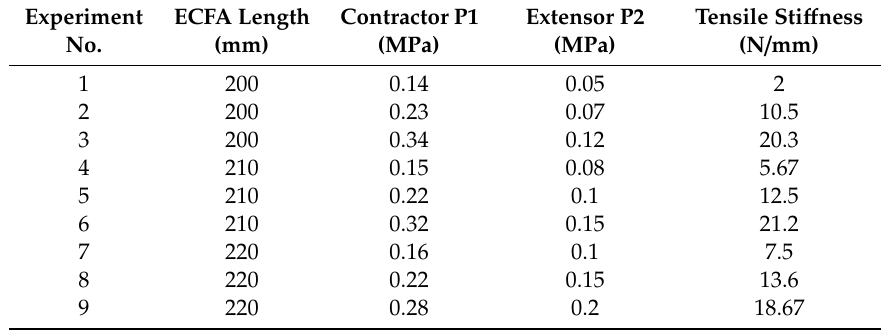
Table 3. Results of varying sti ff ness without length changing of the